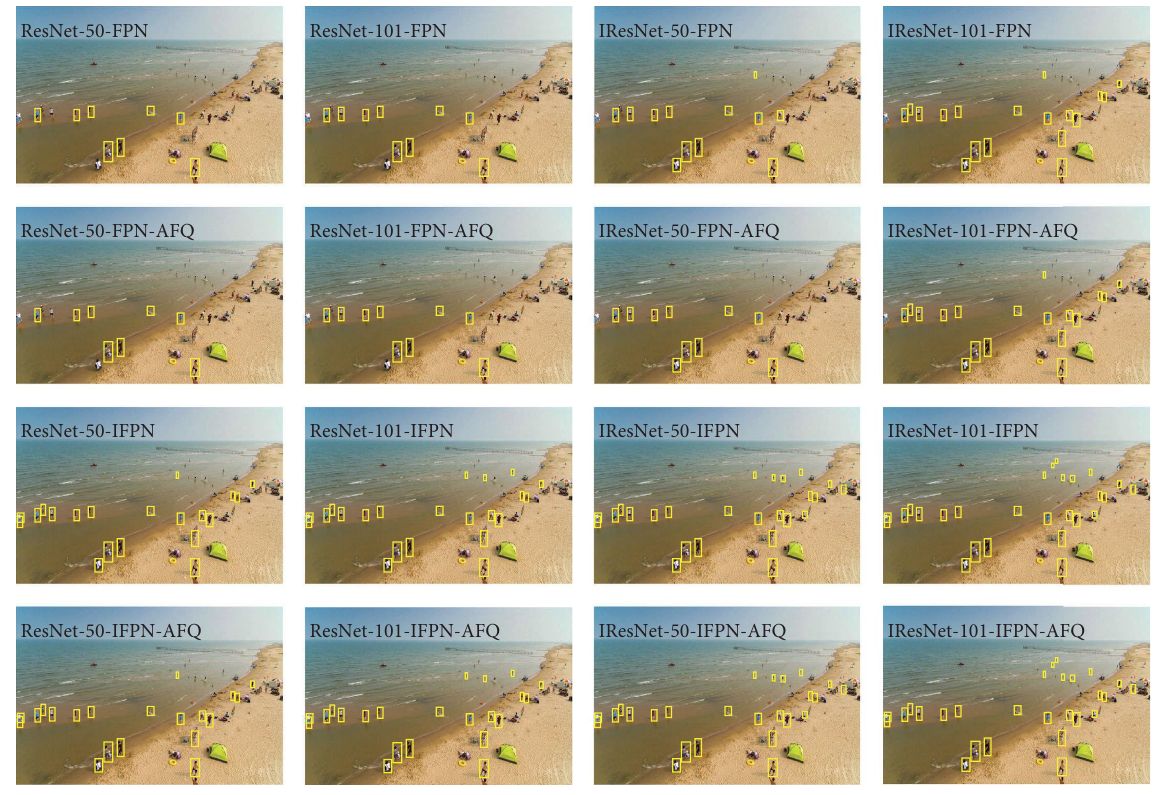
Figure 9: Ablation experiment results. Table 2: Ablation experiment results on the Caltech Pedestrian